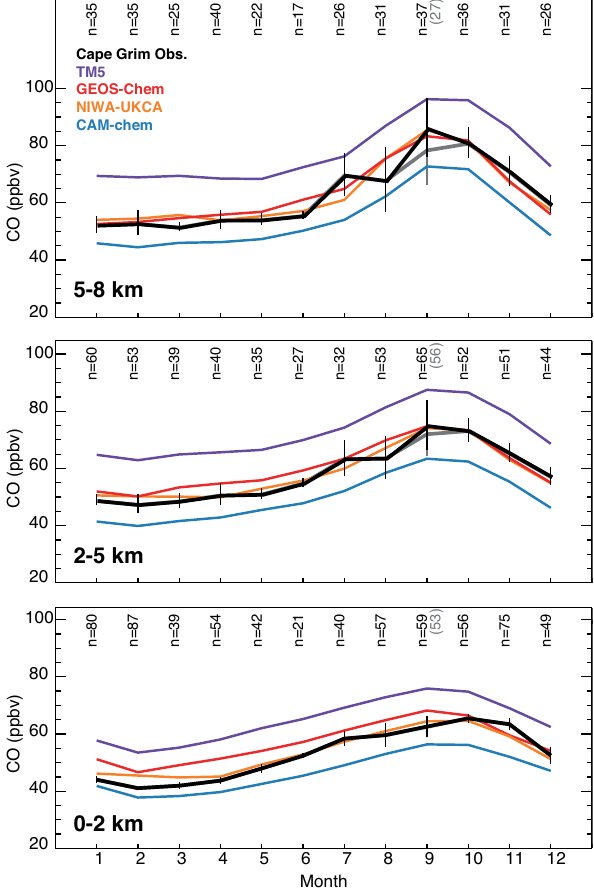
Figure 3. Median monthly CO observed near Cape Grim (1991– 2000; black) and simulated for 2004–2008 in the Cape Grim back- ground region (see Fig. 2) by TM5 (purple), GEOS-Chem (red), NIWA-UKCA (orange), and CAM-chem (blue). Seasonal cycles are shown for 0–2km altitude (bottom), 2–5km (middle), and 5–8km (top). Thin black vertical lines show the observed median absolute deviation across all years of measurement. The number of observed data points in each monthly altitude bin is given at the top of each plot. Shown in gray are the Cape Grim observations from 1991 to 1999 only, excluding the September 2000 SAFARI measurements from the data